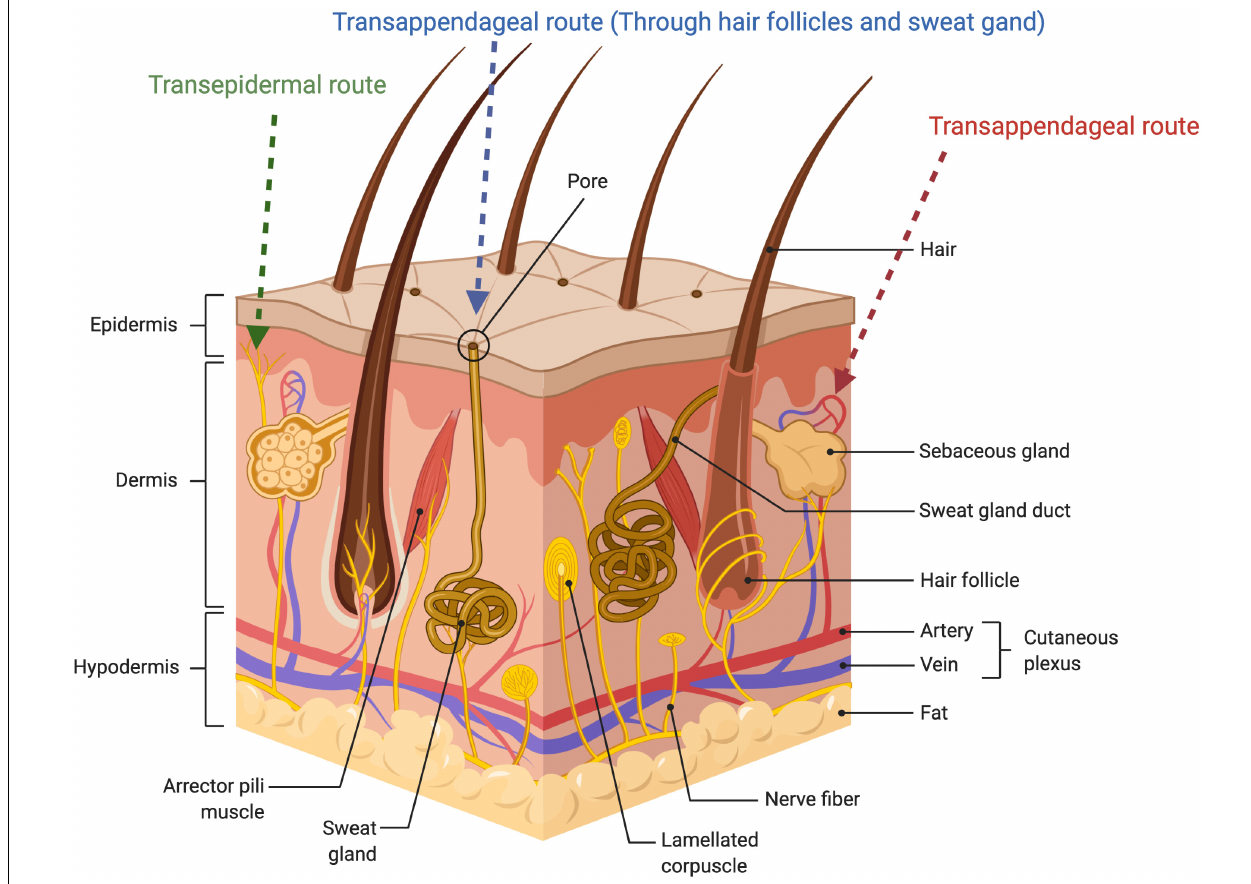
FIGURE 2 | Schematic illustration of the skin layer and showing penetration routes of the drug administered through the